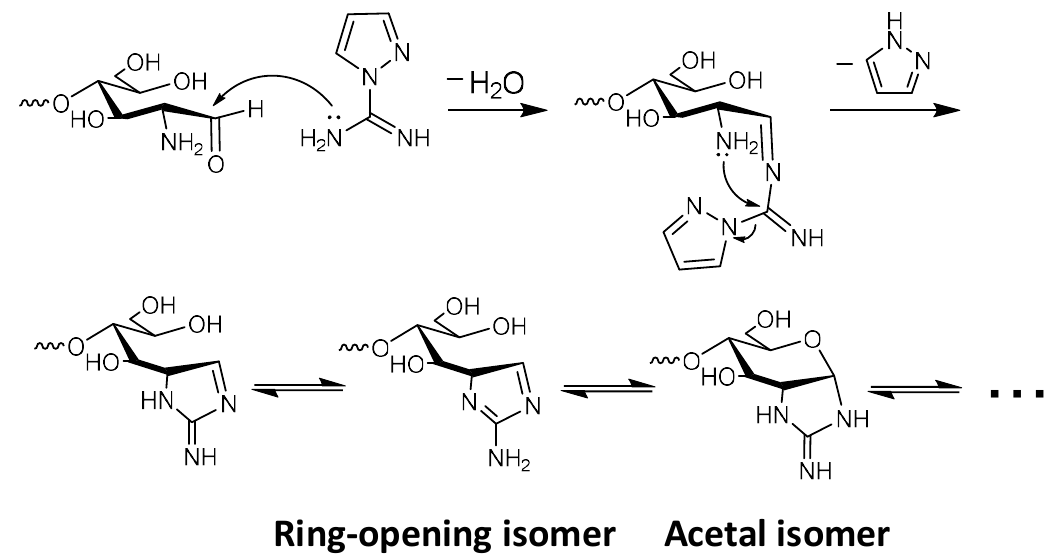
Figure 3. 1 H NMR spectrum of GCOS in D 2 O. The signal attributed to residual acetyl groups was adjusted to 2.0 ppm.